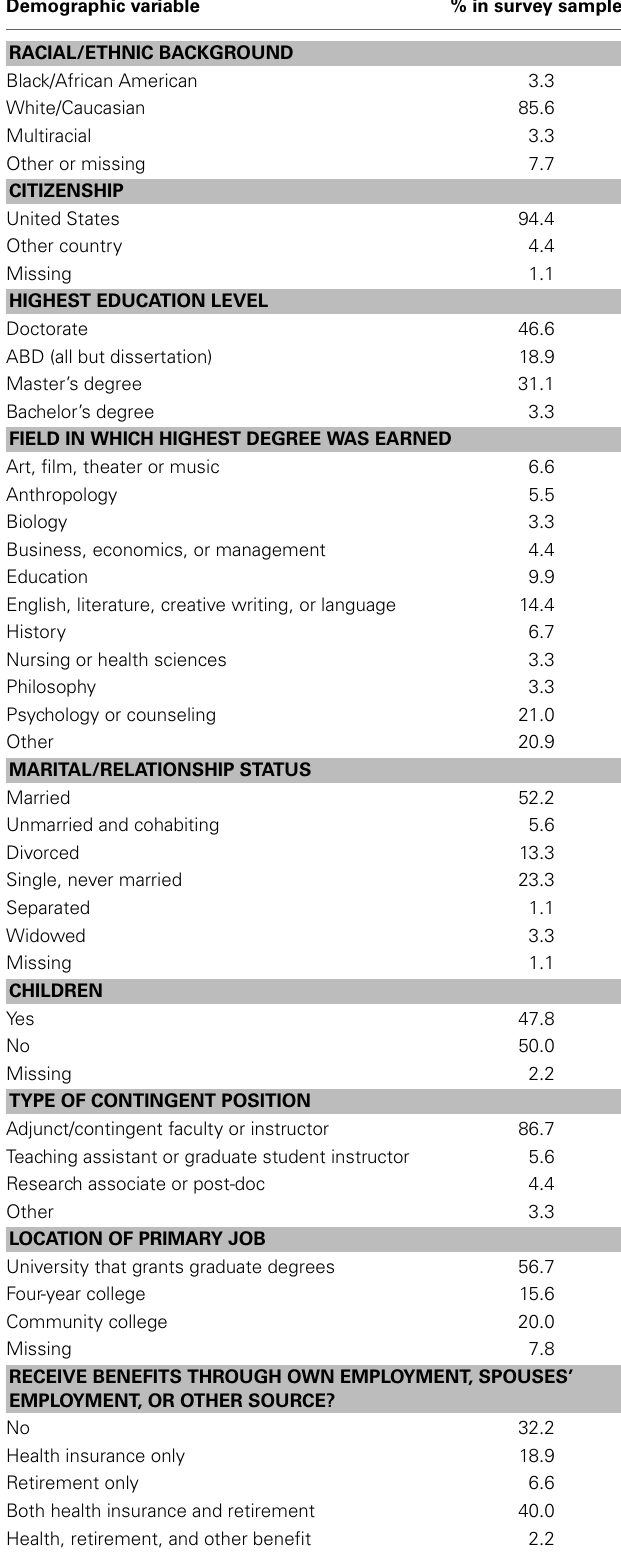
Table 2 | Participants’ demographic characteristics for Part 2 of the